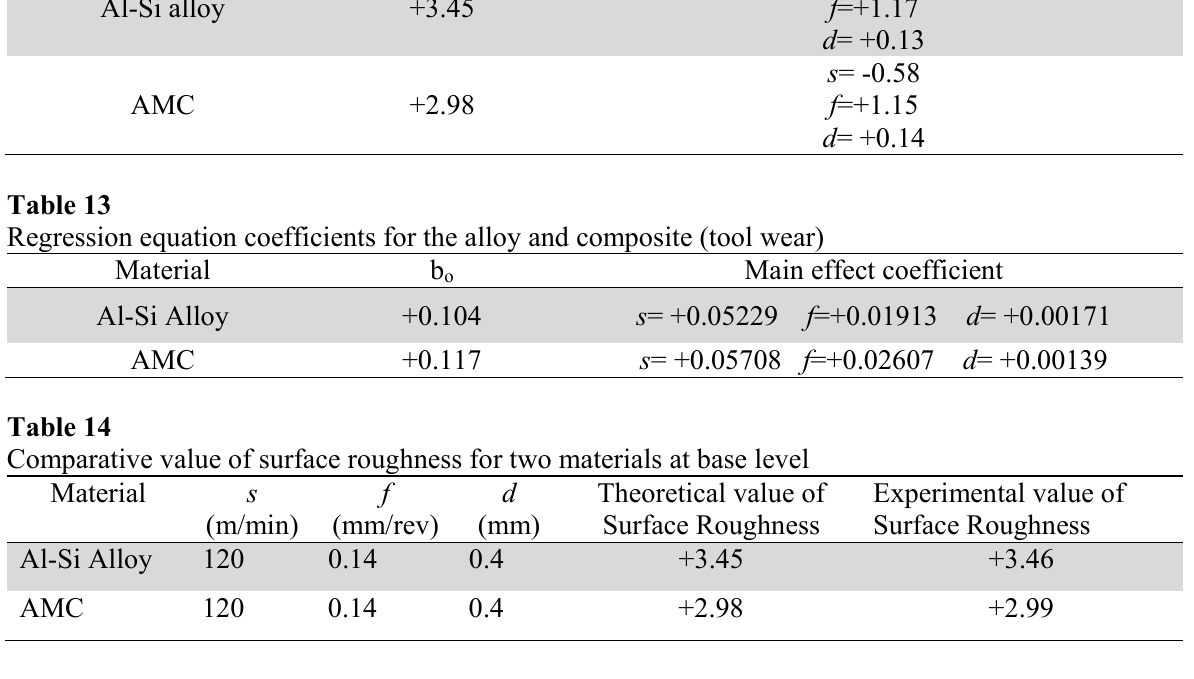
Comparative values of tool wear for two materials at base level Material